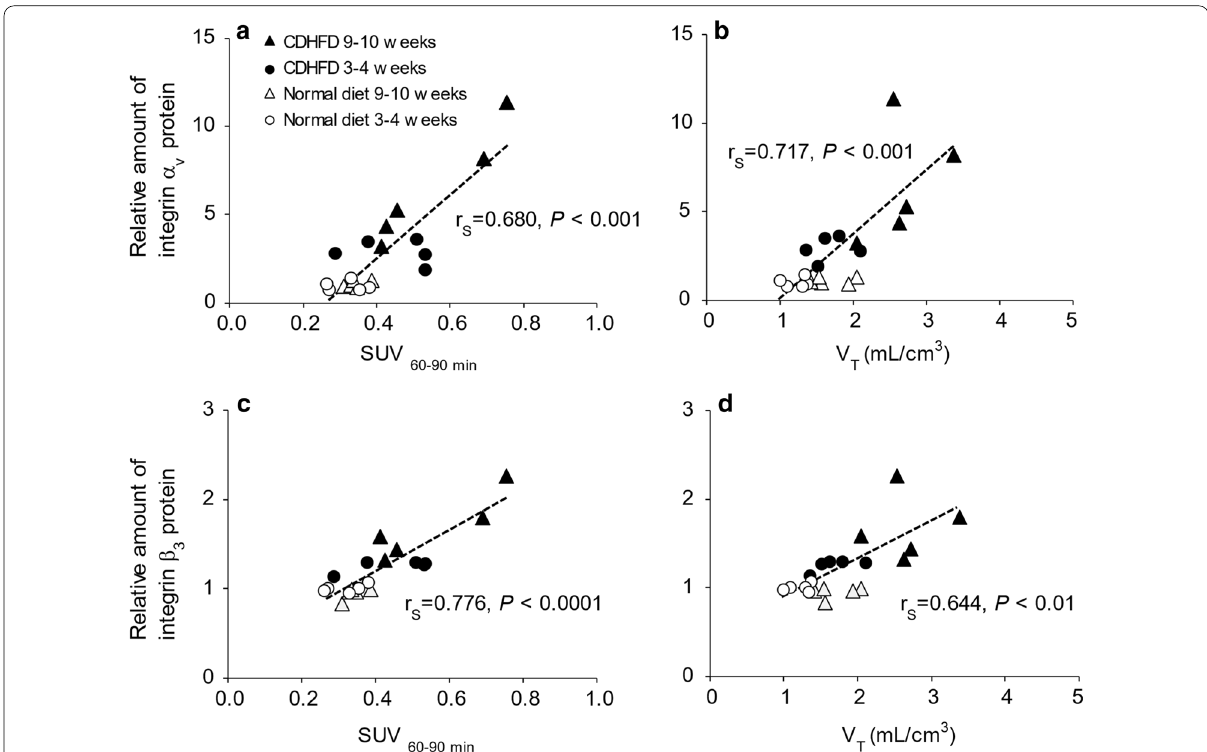
Fig. 7 Correlation analysis of SUV 60–90 min or V T and integrin. Correlation between SUV 60–90 min and a integrin α v and c β 3 protein expression. Correlation between V T obtained using the 2T3C model and b integrin α v and d β 3 protein expression. Vertical axis values are the integrin α v or β 3 protein expression relative to the mean value for the 3–4-week normal diet-fed group. CDHFD choline-deficient, low-methionine high-fat